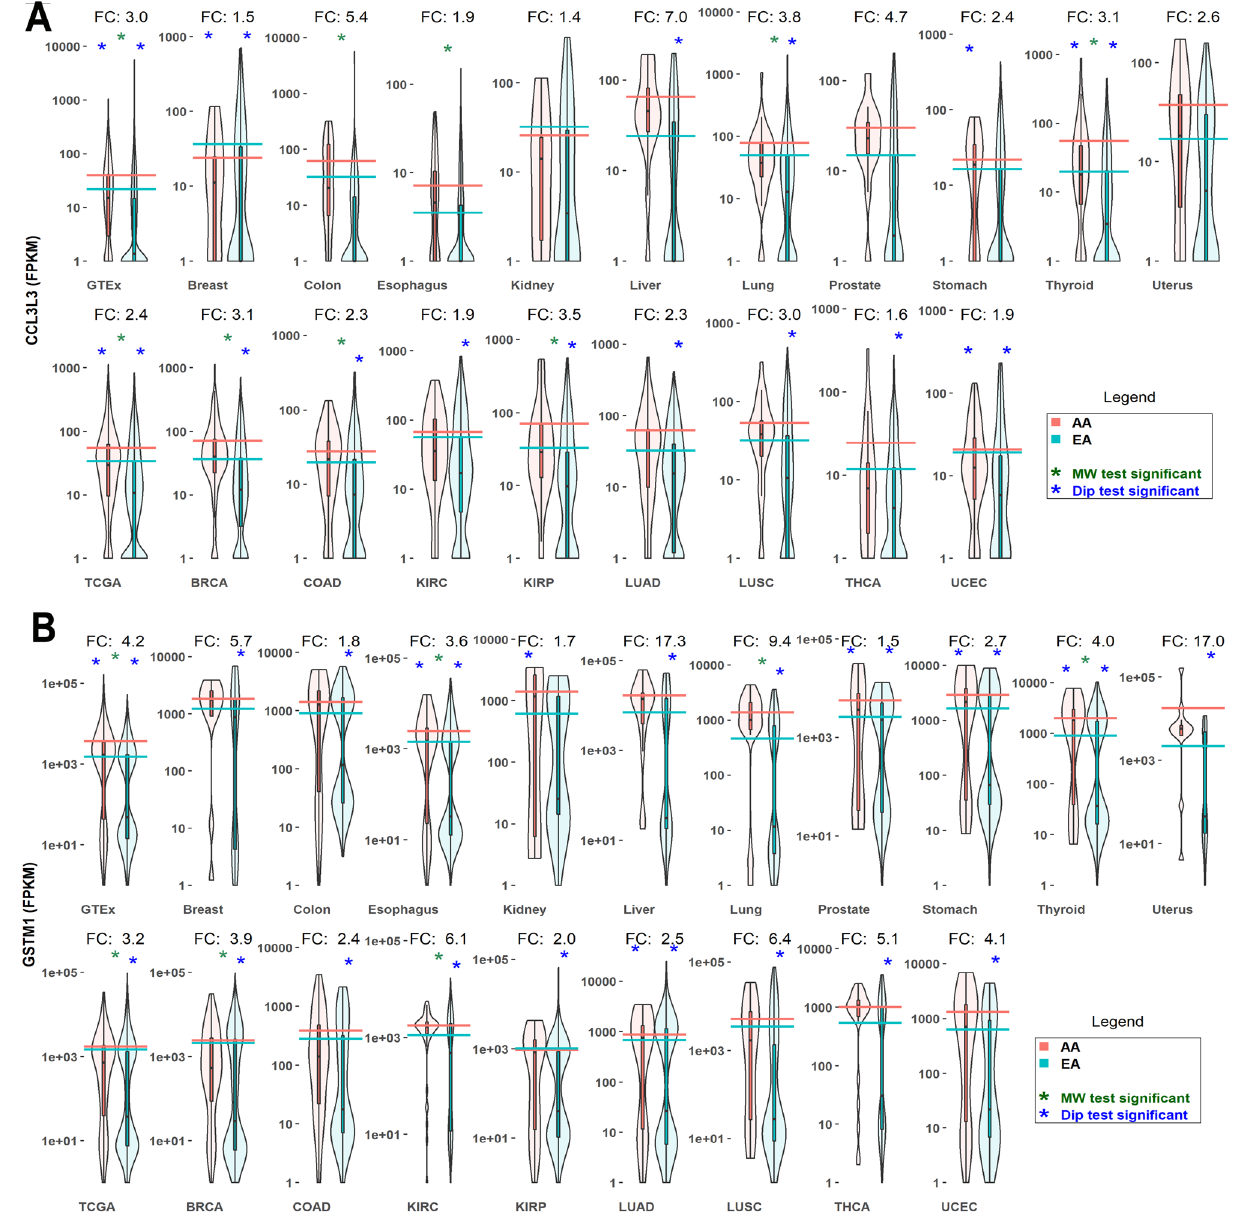
Figure 2. Upregulated expression of chemokine CCL3L3 and mitochondrial glutathione-S-transferase GSTM1 in African Americans compared to European Americans across multiple conditions. ( A ) CCL3L3 is more highly expressed in African Americans over a wide range of tissue-types. CL3L3 binds to chemokine receptor proteins CCR1, CCR3, and CCR5. ( B ) GSTM1 is more highly expressed in African Americans over a wide range of tissue-types. GSTM1 is a key player in metabolism of ROS and xenobiotics. (See Supplementary Tables S2–S28 for complete DE analysis). Violin plots summarize expression over each sample across the two populations. AA African American, EA European American. Horizontal lines represent mean log expression. Green asterisk, Mann–Whitney (MW) test for DE significant (Benjamini–Hochberg (BH) corrected p value < 0.05 ). Blue asterisk, Hartigans’ dip test. Expression distribution is influenced by differences in population sizes (significant p value < 0.05 ). FC, fold change AA/EA. GTEx and TCGA violin plots represent the pooled samples from each project. DE were computed within MetaOmGraph (MOG) 22 , in MOG’s statistical analysis module; R scripts were executed interactively via MOG to generate the violin